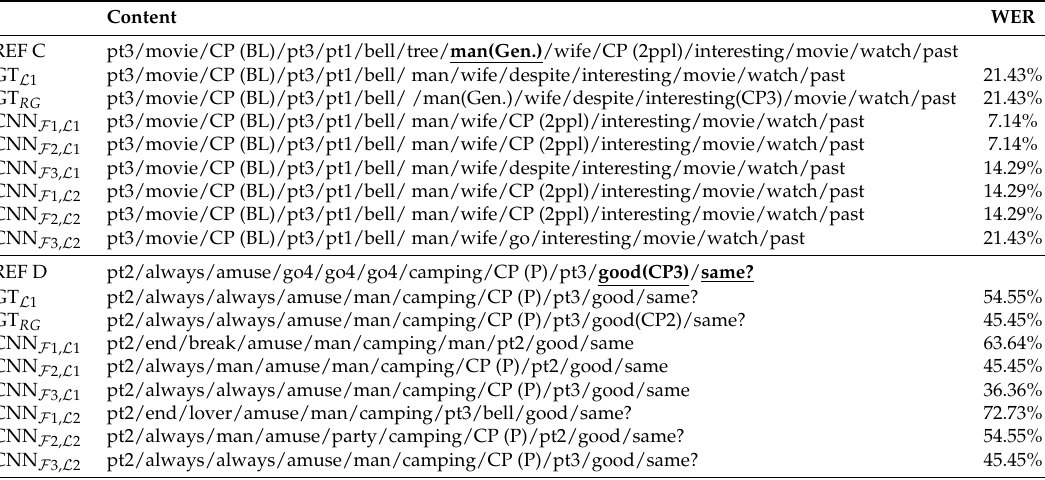
Table 6. Sample outputs suffering from segmentation errors as obtained from the different classifiers in comparison to their reference (REF) and the two ground truths GT L 1 and GT RG . NMEs in REF are highlighted by